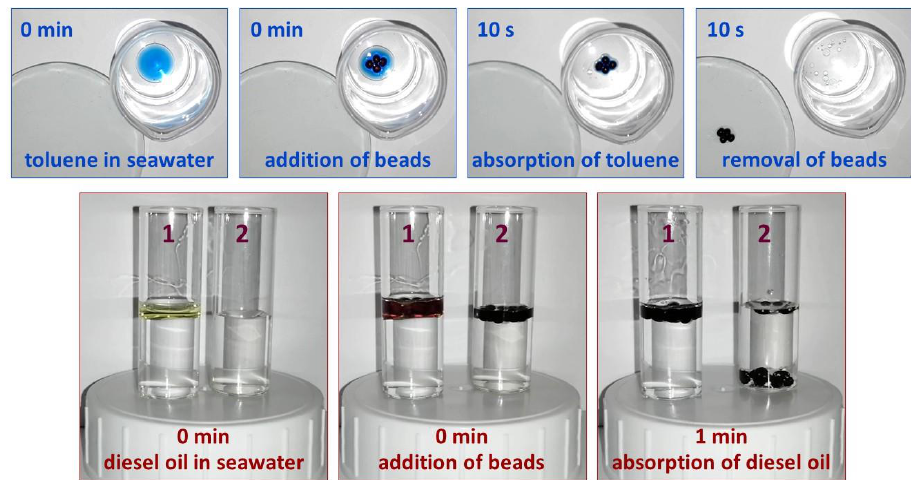
Figure 5. Selective uptake of toluene colored with Sudan blue (top row, view from top) and of diesel oil (bottom row, side view) from seawater using X-Ca-alginate aerogel beads. In the bottom row, vial 1 contains diesel oil and seawater and vial 2 contains only seawater. After 1 min, in vial 1, the beads absorbed diesel oil and they floated, while in vial 2, they absorbed water and they sank.